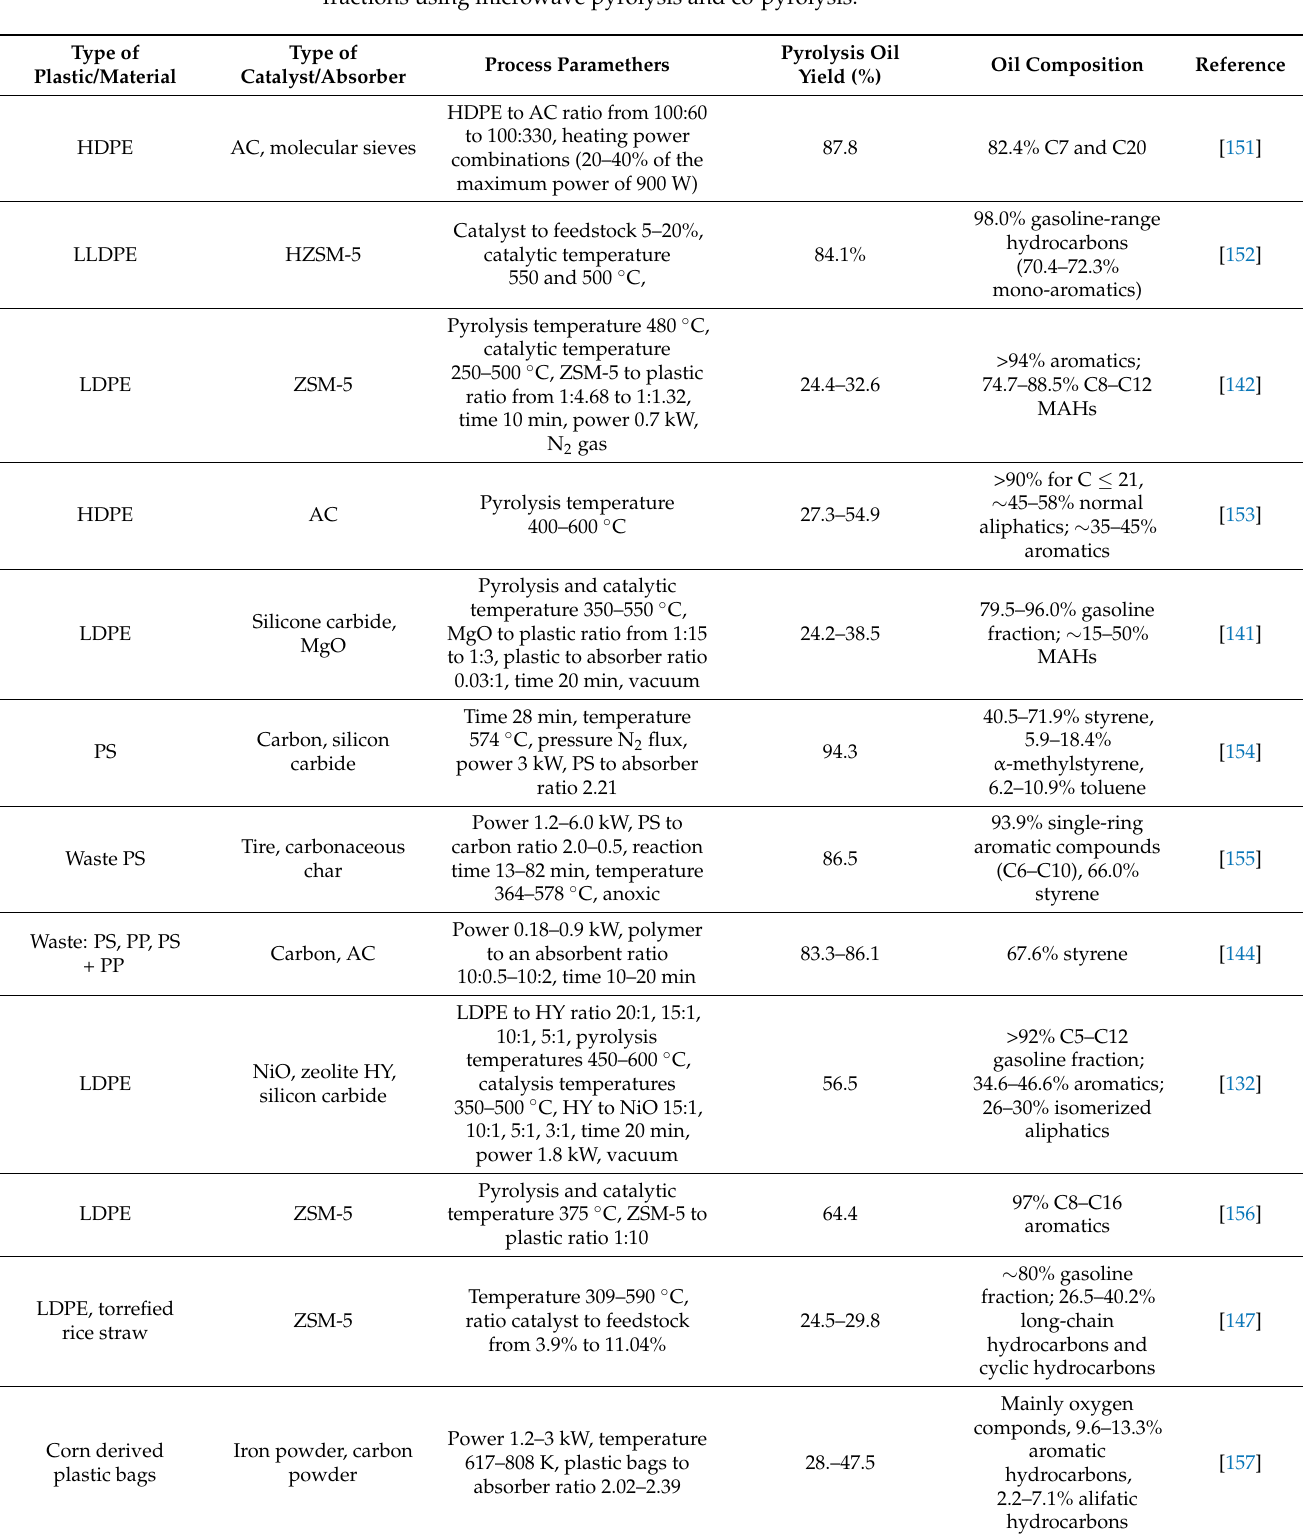
Table 4. Comparison of research works on the conversion of various types of plastic into hydrocarbon fractions using microwave pyrolysis and